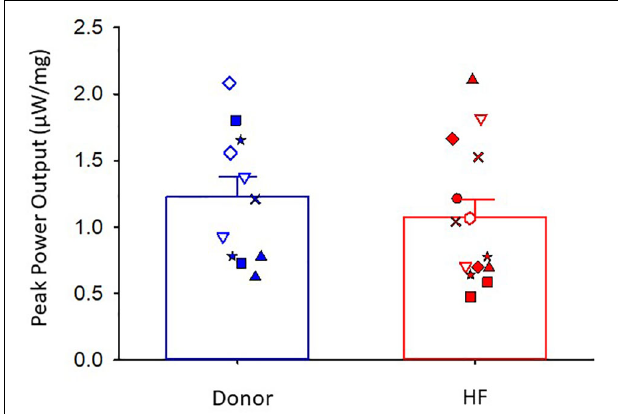
FIGURE 5 | Peak absolute power output. Donor group, N = 6 hearts, n = 11 cardiac myocyte preparations. HF group, N = 8 hearts, n = 14 cardiac myocyte preparations. Different symbols indicate data points from each heart sample. Linear mixed model, p =